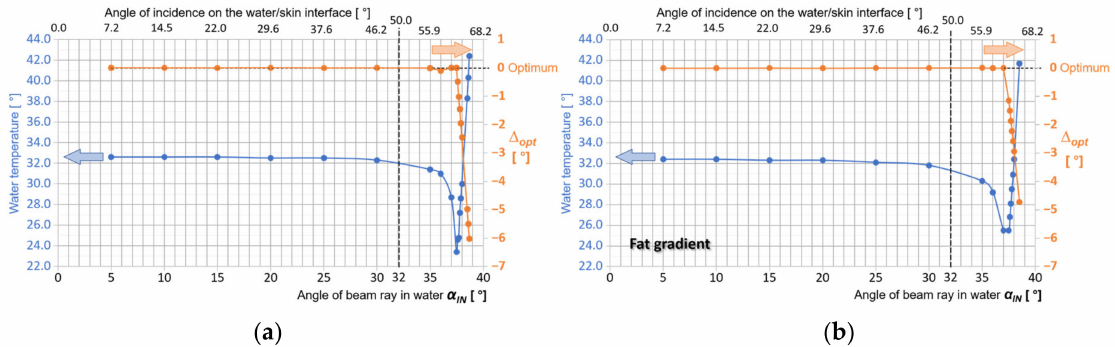
Figure 12. Results of optimization of the water temperature obtained with the developed models for the parameter ∆ opt : without ( a ) and with temperature gradient ( b ) in the fat